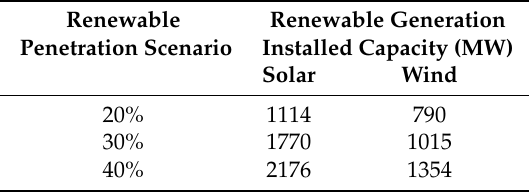
Table 4. Renewable generation installed capacities in the different renewable penetration